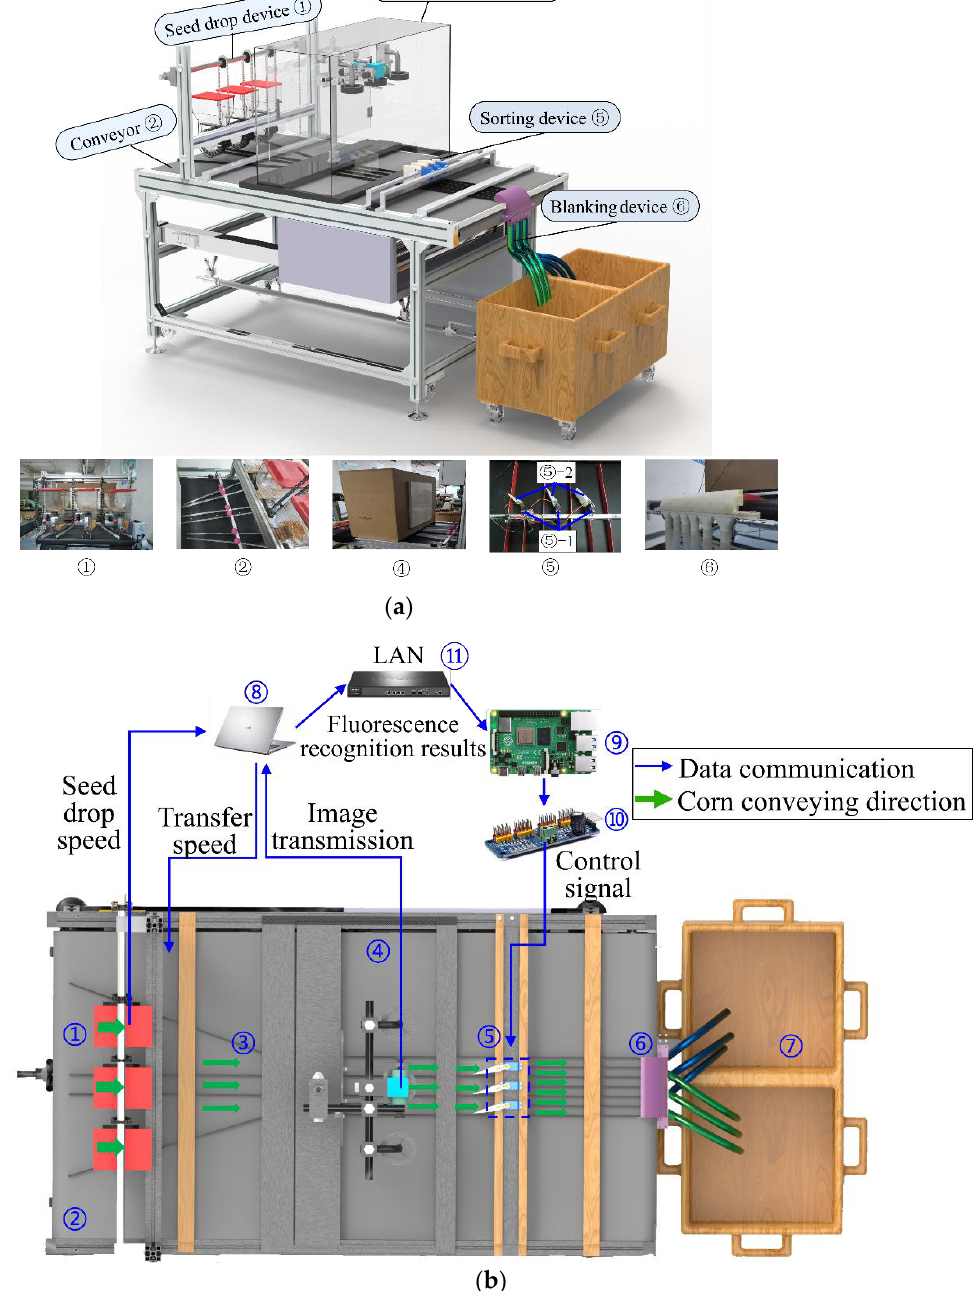
Figure 5. Maize kernel sorting system: ( a ) structural design, and ( b ) control system design.